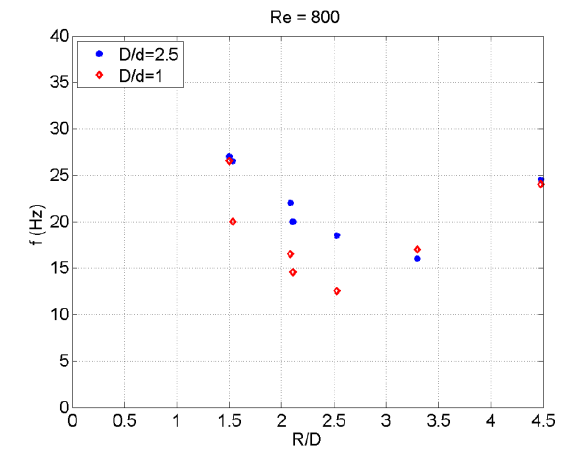
Figure 5. Relationship between the frequency and the pitch distance for Re